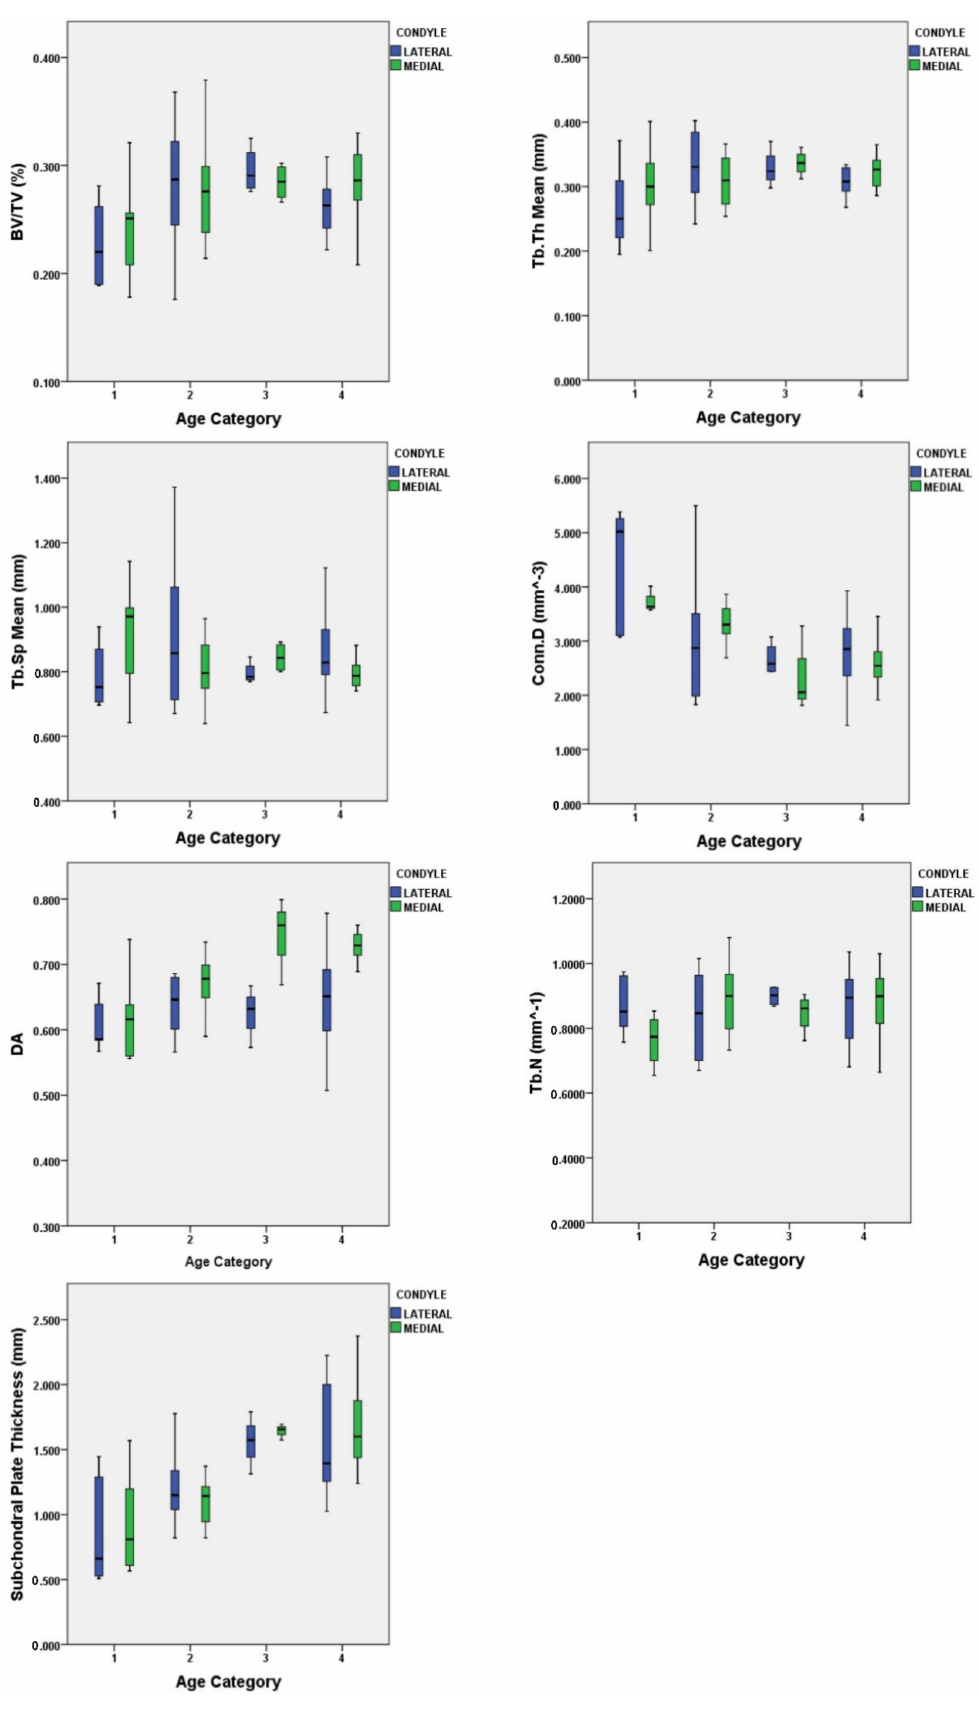
Figure 5. All morphometric parameters by condylar region across age